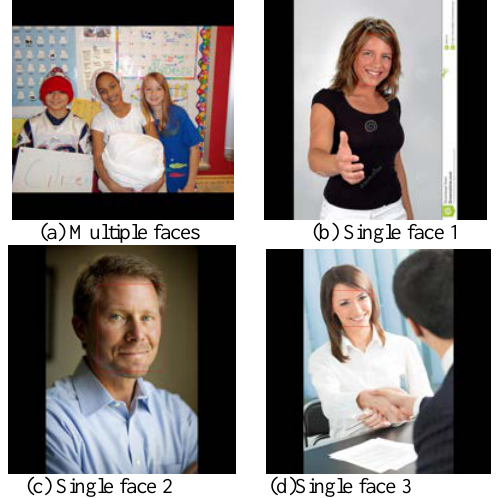
Fig. 2. Data set after